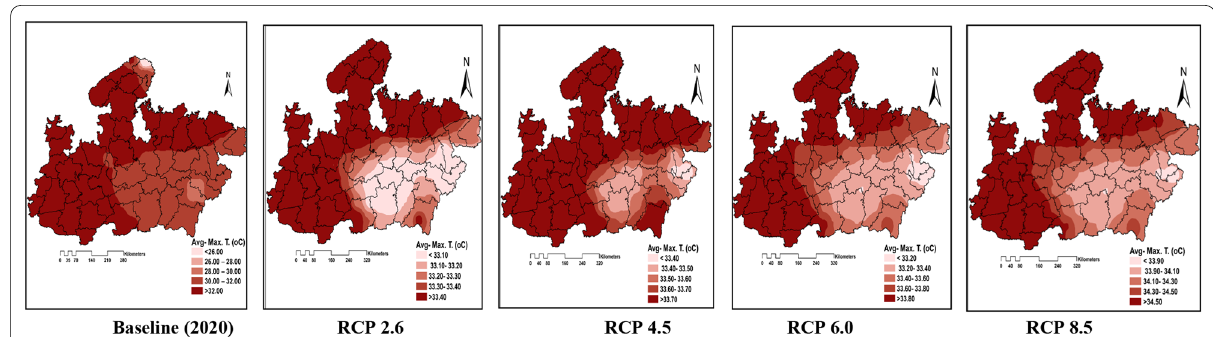
Fig. 7 Predicted change in the maximum temperature relative to baseline over the whole Madhya Pradesh state under different RCP scenarios 2050. Under all the RCP scenarios, the average maximum temperature is projected to increase